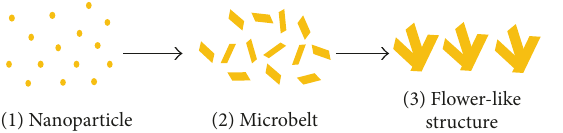
Figure 9: Scheme of Alq 3 growth from nanoparticles to flower-like structures. Illustrations (1), (2), and (3) correspond to the SEM images of Figures 7(a), 7(b), and 7(c),